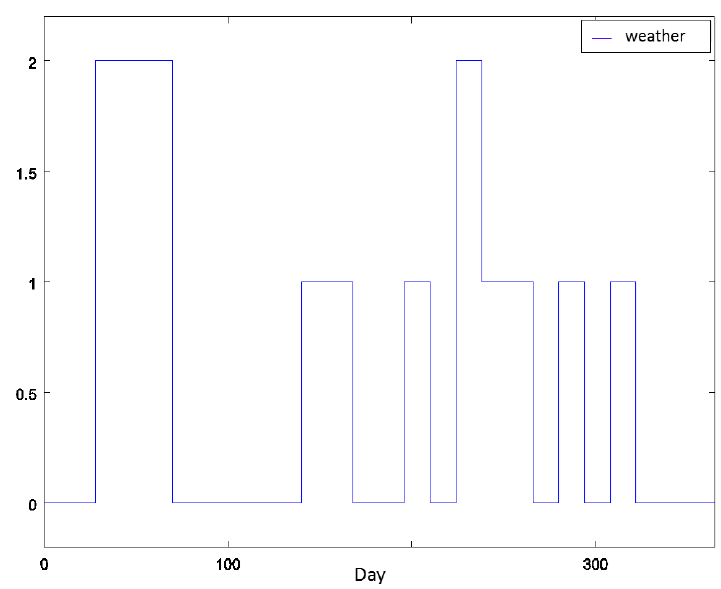
Figure 7. Weather profile over a year. Notes: 0, dry weather; 1, rainy weather; 2, stormy weather.